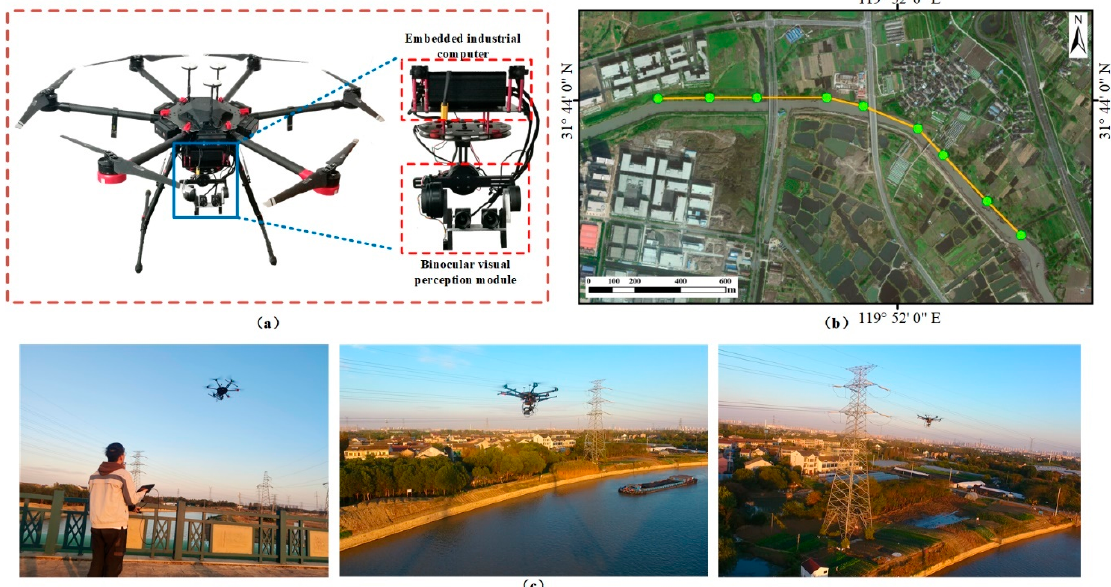
Figure 14. 220 kV inspection flight roadmap and field test map of the proposed UAV inspection system: ( a ) hardware structure diagram of UAV system; ( b ) inspection route map; ( c ) the scene of UAV inspection.